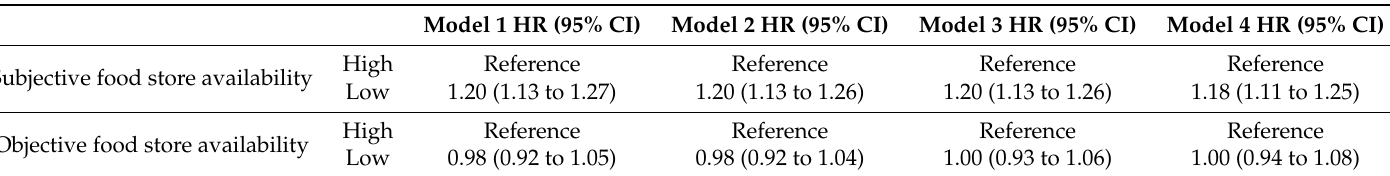
Table 3. Hazard ratios with 95% confidence intervals for incident functional disability with objective and subjective food store